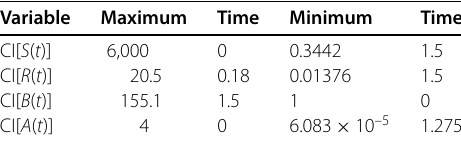
Table 6 Extremum values of the confidence intervals